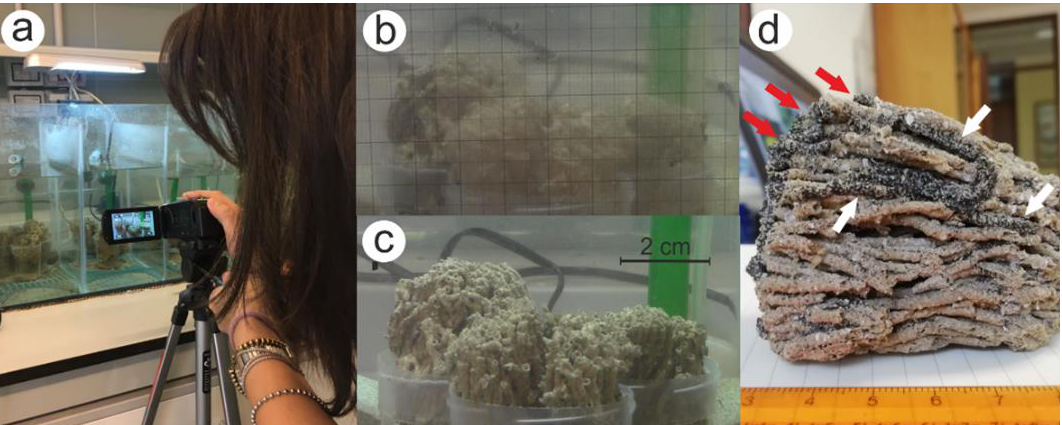
Figure 5. Observation of polychaete activity by using videos and direct measurements at the end of the tests. ( a ) Acquisition of photos and videos during the activity of the polychaetes. ( b ) First shot pictures with the transparent graph paper used as a reference scale. ( c ) Second shot focused on the three replicas of each tank. ( d ) Example of the growth of the tubes measured at the end of the experiments. Note that tube growth occurred on top of the reef fragment (red arrows) and in the lateral sectors of this biological replica (white